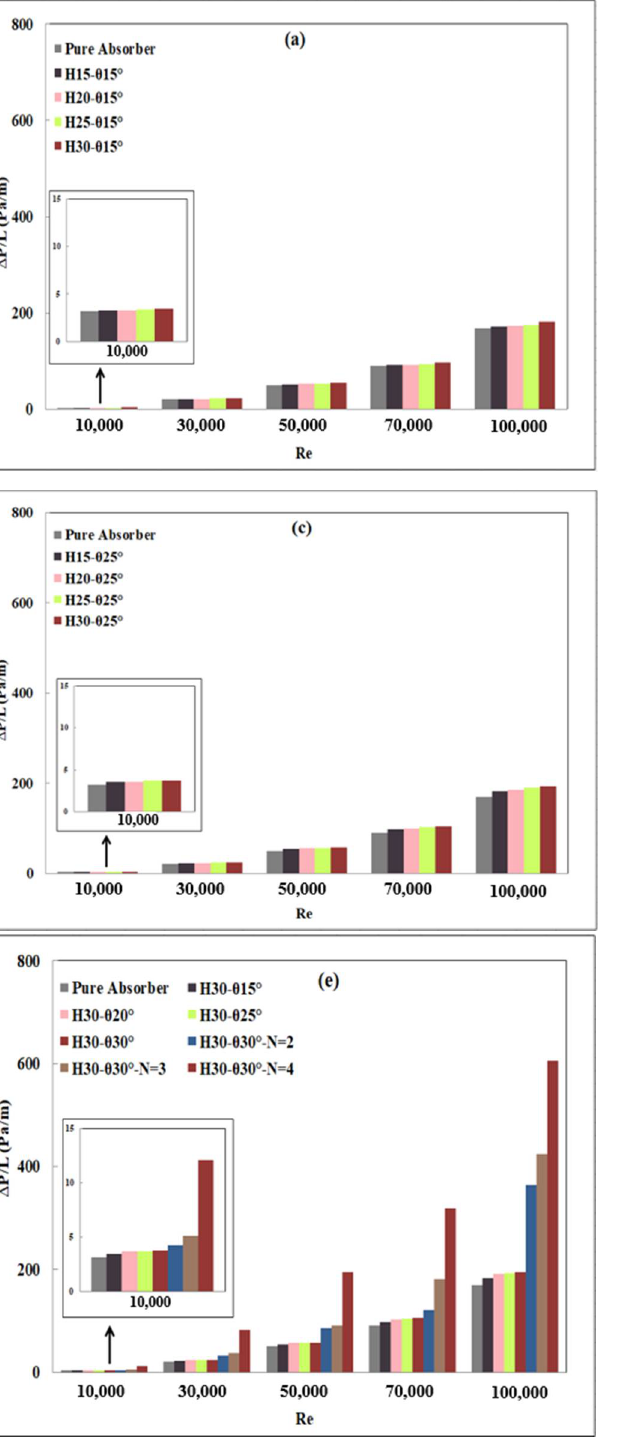
Figure 15. Pressure drop changes in the presence of swirl generators with and without nanofluid. ( a ) Pitch height variation with θ = 15°, ( b ) Pitch height variation with θ = 20°, ( c ) Pitch height variation with θ = 25°, ( d ) Pitch height variation with θ = 30° , ( e ) Pitch angle ( θ ) and number of inserts (N) variation with fixed pitch height, ( f ) Optimal configuration with and without